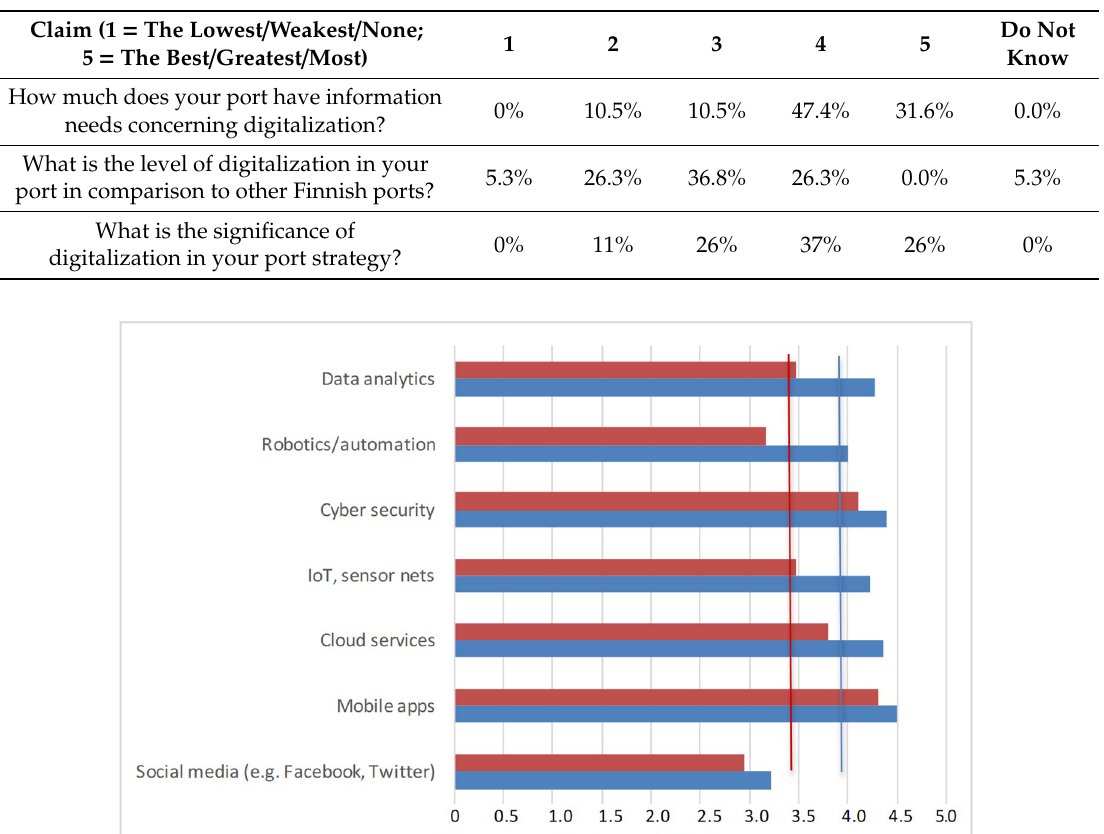
Table 1. Distributions of survey responses (in percentages) to the three key questions (claims).